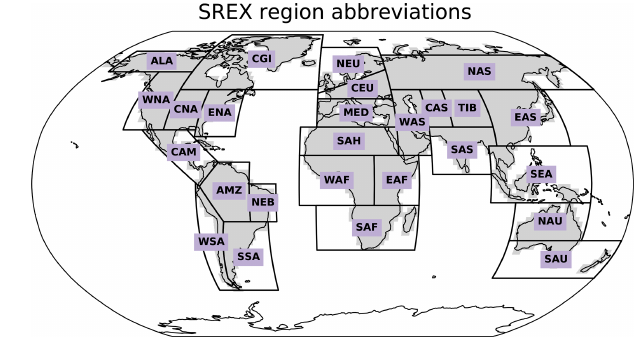
Figure 1. Map of the SREX regions and their abbreviations. The considered land grid points are shown in